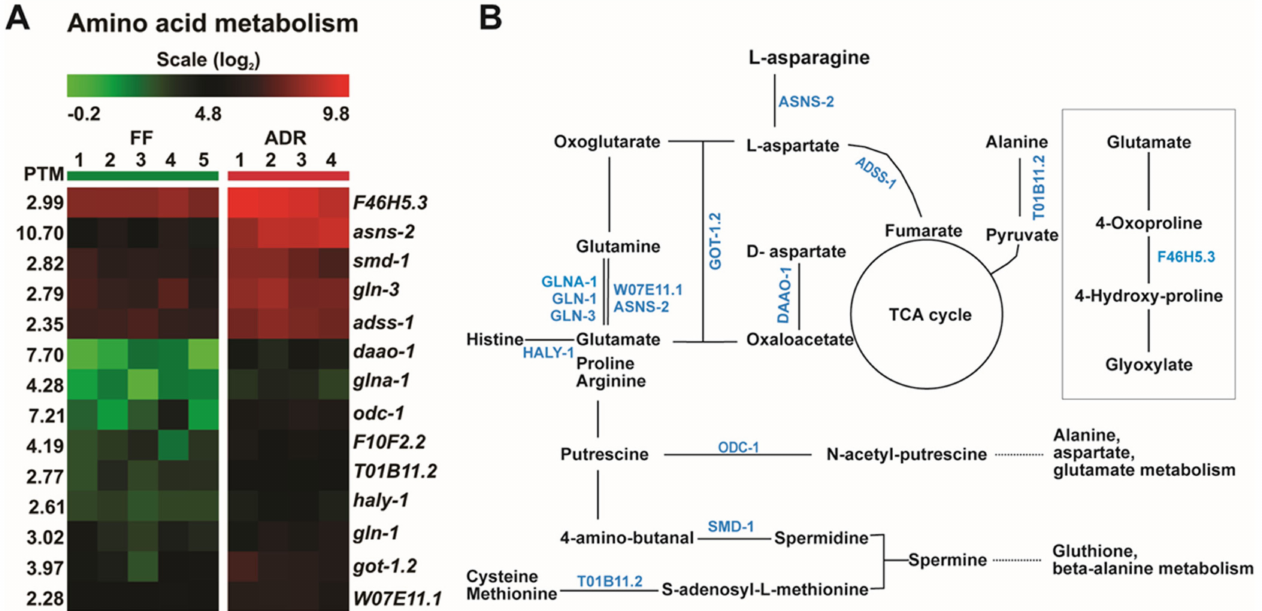
Figure 4. Heatmap and metabolic pathway of DEGs in amino acid metabolism. ( A ) General up- regulation of genes in amino acid metabolism. ( B ) Part of the amino acid metabolic pathway (enzymes are marked in blue). FF = fully fed, ADR = axenic dietary